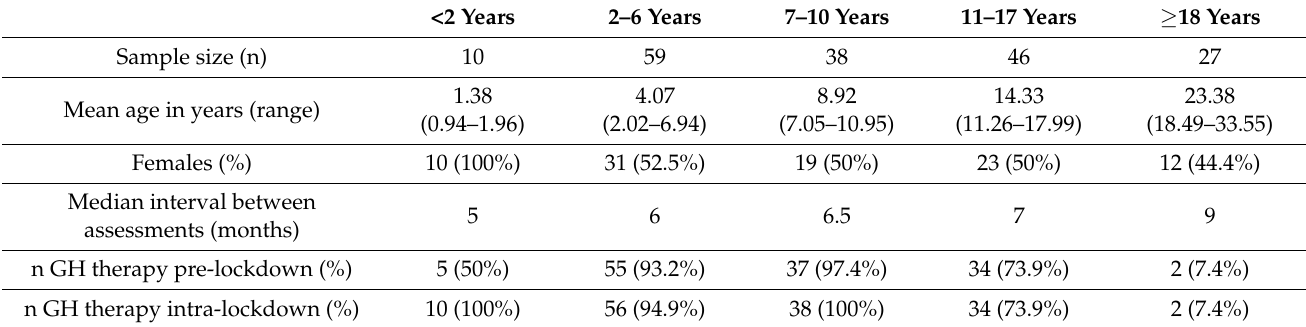
Table 1. Characteristics of children and adolescents with PWS during the lockdown in March–April